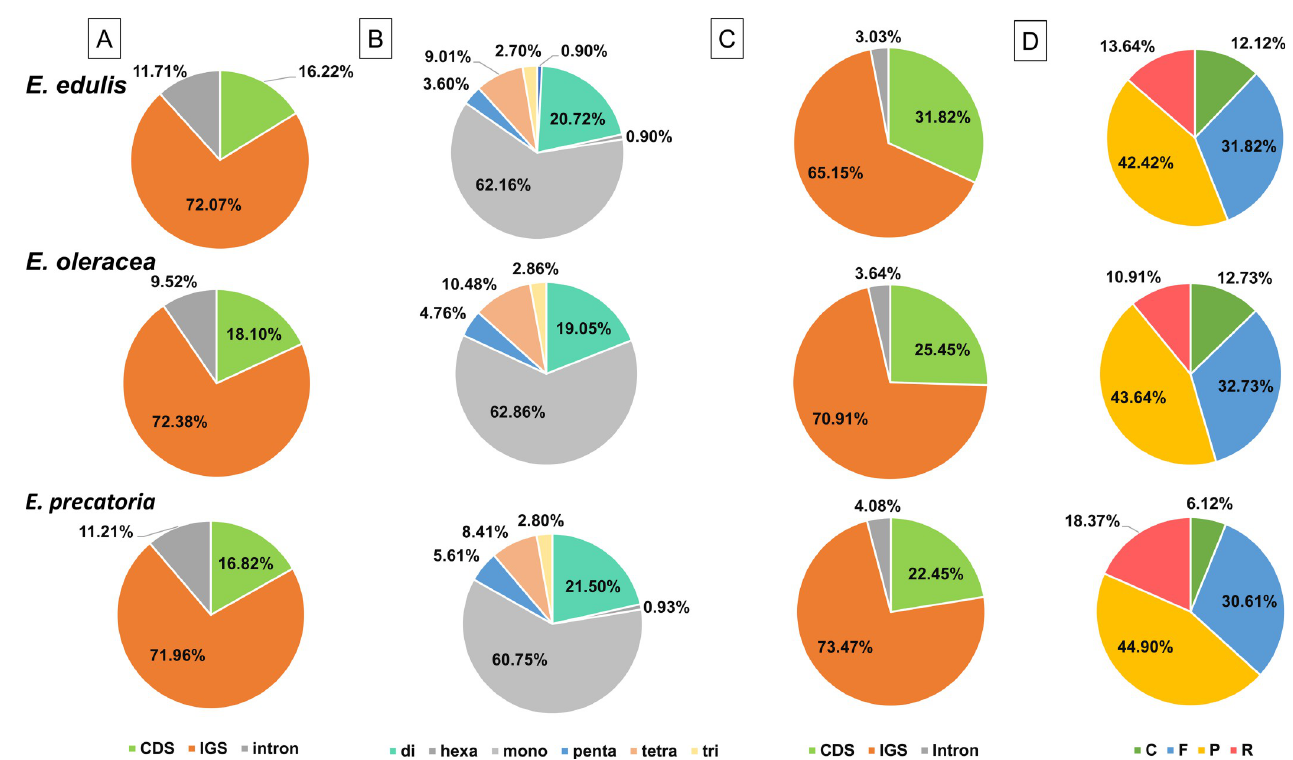
Fig 4. Distribution and classification of SSR and dispersed repeats in the chloroplast genomes of Euterpe edulis , E . oleracea and E . precatoria . (A) Proportion of coding and non-coding regions containing SSRs; (B) Proportion of different types of SSR present in the chloroplast genomes; (C) Proportion of regions containing repeats; (D) Frequency distribution of different types of repeats: F = Forward, P = Palindrome, R = Reverse and C = Complement. CDS = Coding sequence, IGS = Intergenic